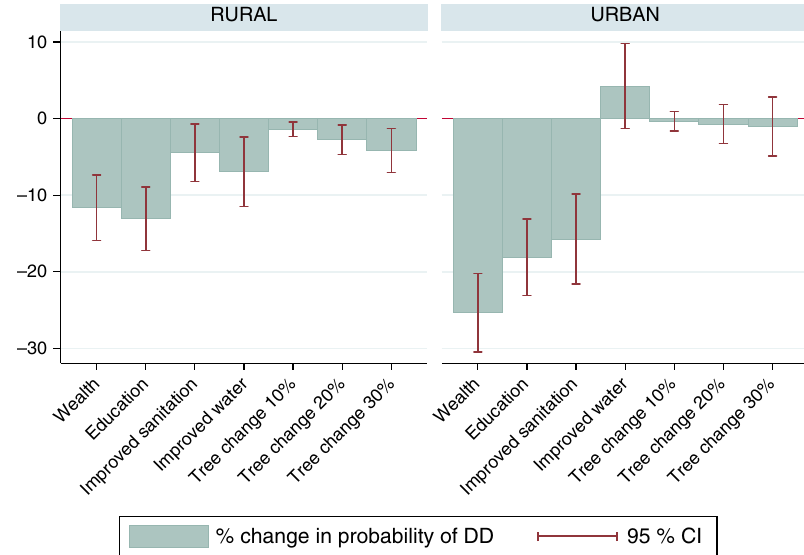
Fig. 3 Marginal effects of policy options for reducing childhood diarrheal disease. Reductions in the probability of diarrhea and 95% con fi dence intervals for wealth, education, improved sanitation, improved water, and increases in tree cover of 10, 20, and 30%. Marginal effects of tree cover are only statistically signi fi cant for the rural subset. The effect of a 30% increase in tree cover is approximately the same as the effect of an improved sanitation facility, but lower than the effect of improved water, education, and